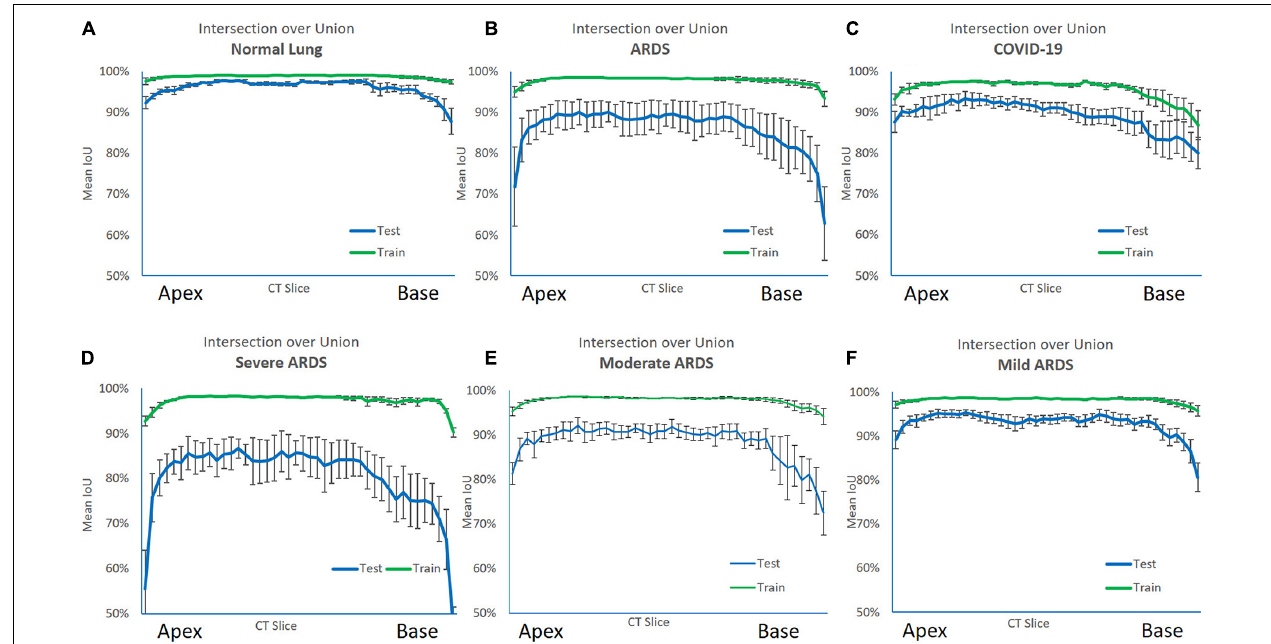
FIGURE 8 | Intersection over Union (IoU) metric performance on the training (green line) and test set (blue line) along the cranio-caudal axis in normal lungs (A) , ARDS (B) , COVID-19 (C) , severe ARDS (D) , moderate ARDS (E) , and mild ARDS (F) . As shown, in the training set, the AI algorithm almost perfectly matched the manual segmentation. In the test set the performance was slightly poorer. The Figure also shows the anatomical distribution of the error. Indeed, the algorithm was able to achieve a higher performance in the middle of the lung, while at the apex and the base, locations where also for a trained eye is sometimes difficult to distinguish the lung parenchyma from the surrounding structures and the pleural effusion, as is the case with severe ARDS (D) , it struggled more.